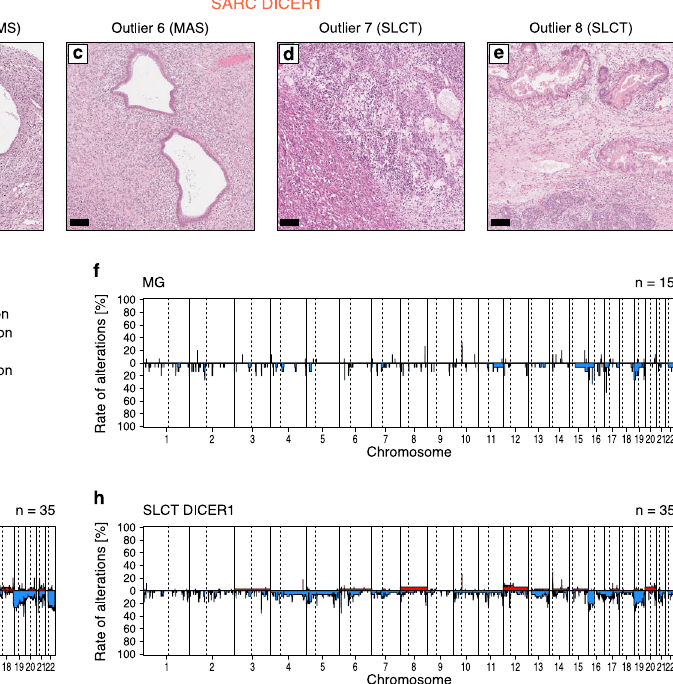
evaluation of individual outliers diagnosed as MAS, MAS/ERMS or SLCT revealed ( d ) rhabdomyosarcomatous differentiation in a subset ( n =2) of tumors. Hema- toxylin & Eosin, scale bar equals 100 μ m. Cumulative copy number pro fi les of molecularclassesof f MG, g MASand h SLCTDICER1showingthefrequencyofany chromosomal aberration at the respective loci (related to Supplementary Fig. 2). Chromosomal gains are depicted in red, and losses shown in